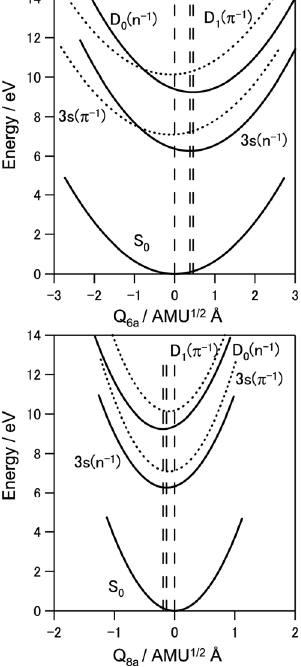
Figure 13. Harmonic potential curves along with 6 a and 8 a normal coordinates for pyrazine determined from spectroscopic data. The equilibrium geometries in the 3s( n − 1 ) and D ( n − 1 ) states differ significantly from that of the ground state. The equilibrium 0 geometry of the 3s( n − 1 ) state differs from that of the D permission from Ref. [64], copyright (2008) by American Chemical